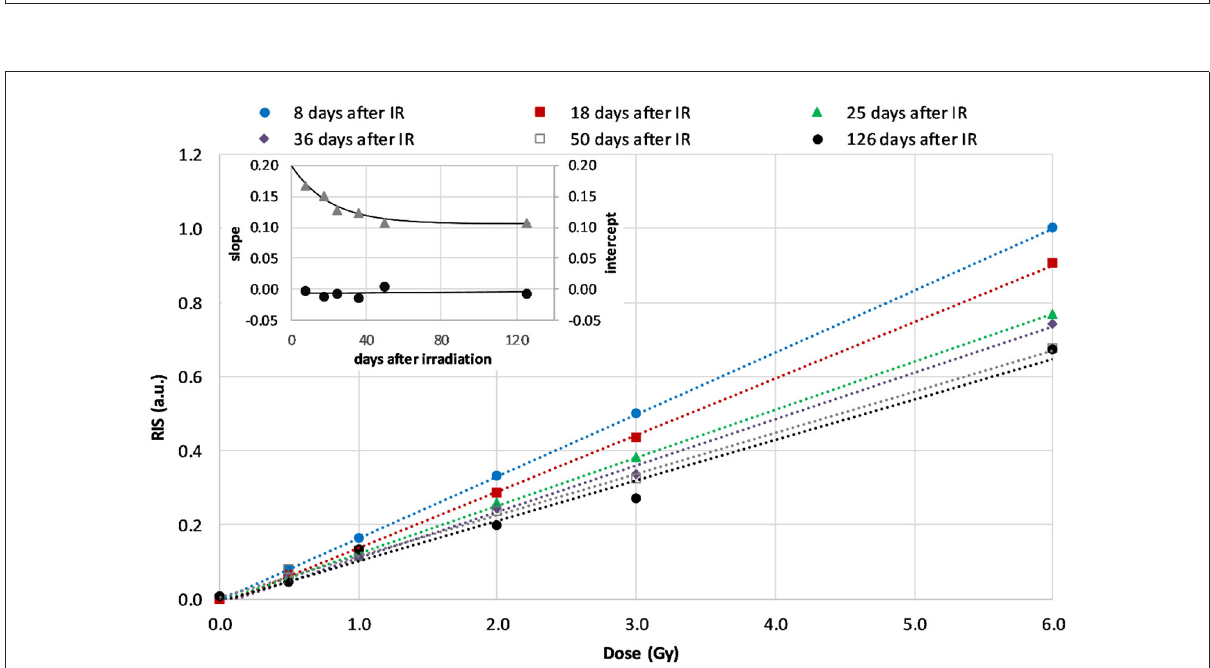
FIGURE4 Calibration lines for WG measured at 8 th , 18 th , 25 th , 36 th , 50 th , and 126 th day after irradiation (dashed lines are linear regressions of the data). The inset shows time dependence of the slopes (the rate of decay of the RIS, triangles) and intercepts (circles) of the regression lines in the first 126 days after